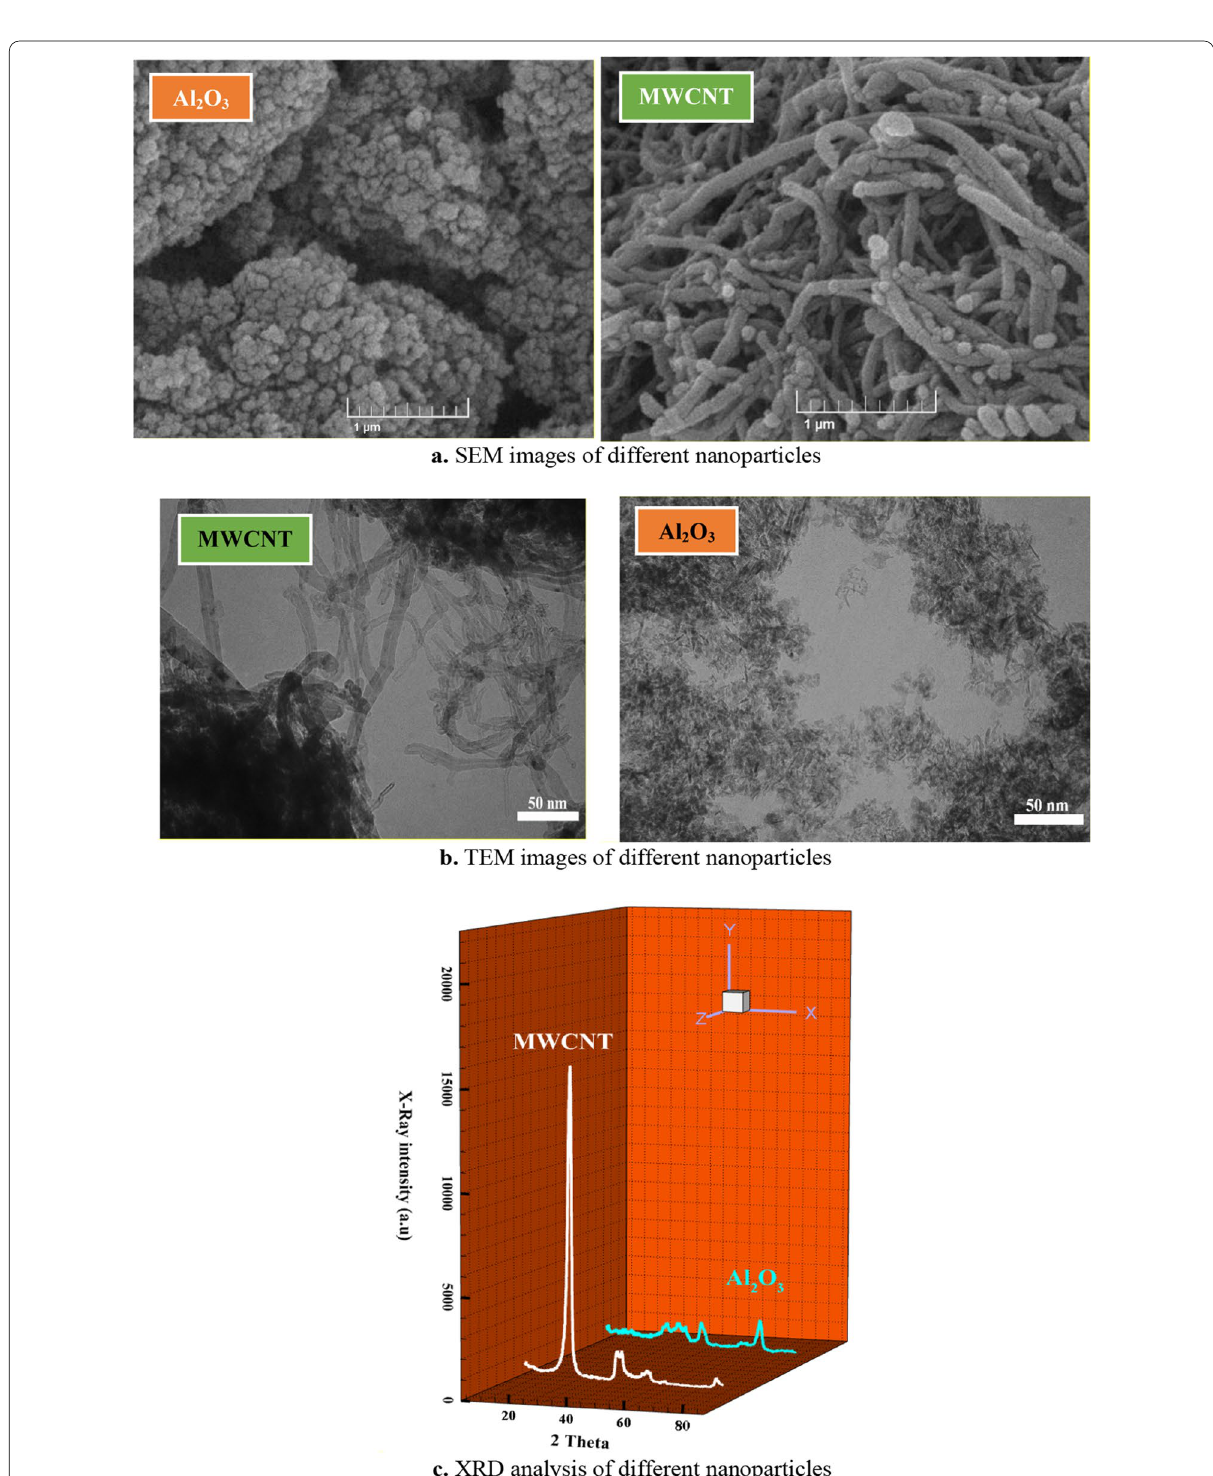
Fig. 5 Images related to the use of SEM and TEM methods and XRD